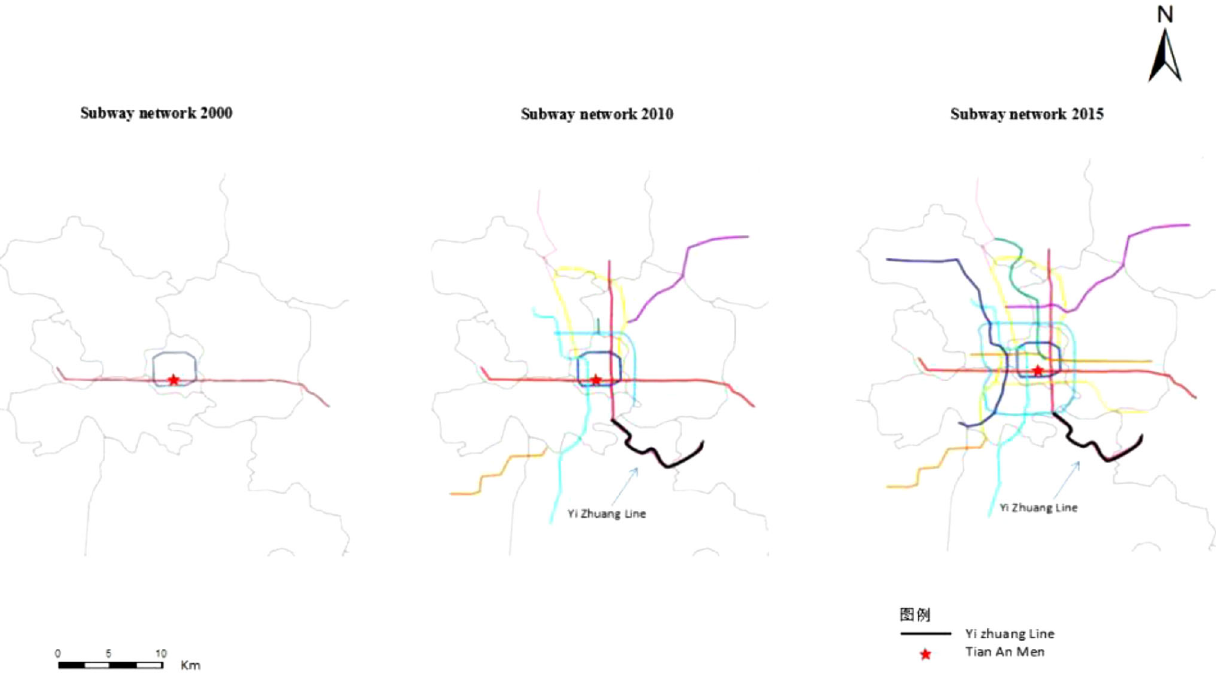
Fig. 2 Rapid development of urban rail transportation in Beijing and Yizhuang light rail